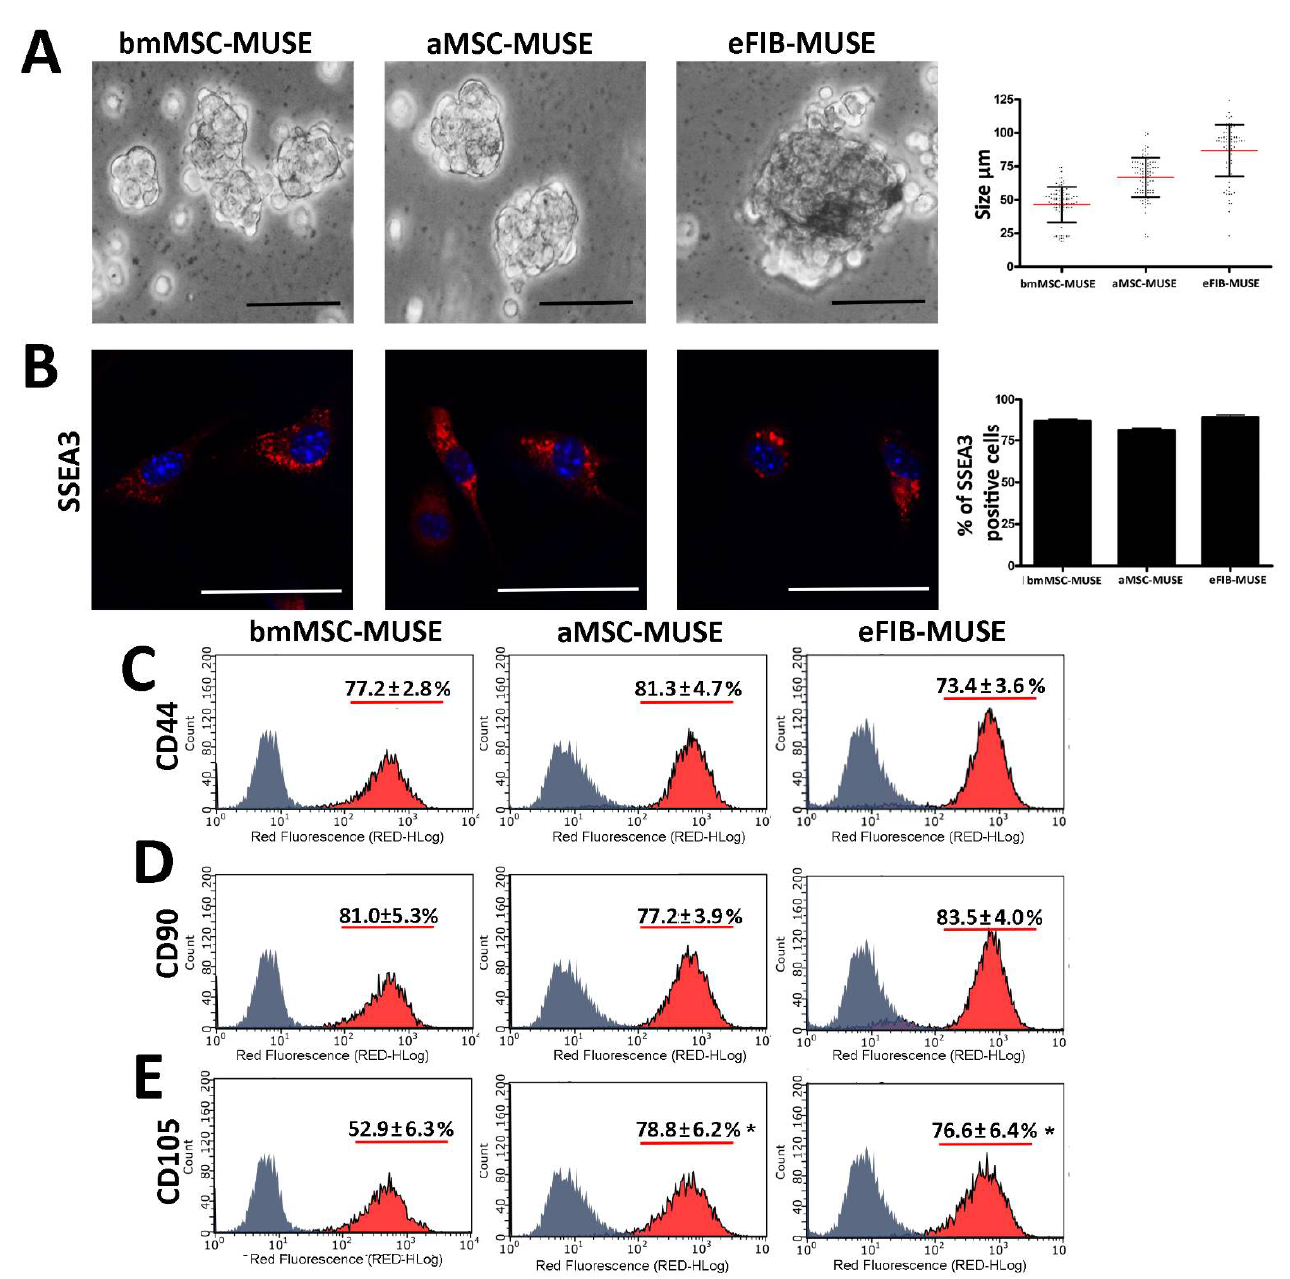
Figure 1. MUSE cells were isolated from bone marrow MSCs (bmMSC-MUSE), subcutaneous adipose tissue MSCs (aMSC- MUSE), and ears fibroblast (eFIB-MUSE). ( A ) Microscopy pictures of MUSE cell clusters showing different sizes. The picture shows representative samples. Scale bars = 50 µ m. The graph displays the size of MUSE cell clusters. Each dot corresponds to one MUSE cell cluster. The red bar represents the mean size value in the different cell populations. ( B ) Representative microscopic field of SSEA3 staining (red) in MUSE cells. The nuclei were counterstained with DAPI (blue). The histogram shows the percentage of SSEA3-positive cells in each population. The data are expressed with standard deviation ( n = 5). ( C – E ) Expression of CD44, CD90, and CD105 surface markers measured by flow cytometry in MUSE cells derived from mouse stromal tissues. The data are expressed with standard deviation ( n = 5). We compared the three MUSE cell populations. The statistical differences among bmMSC-MUSE and the other MUSE cell populations are indicated with * (* p <